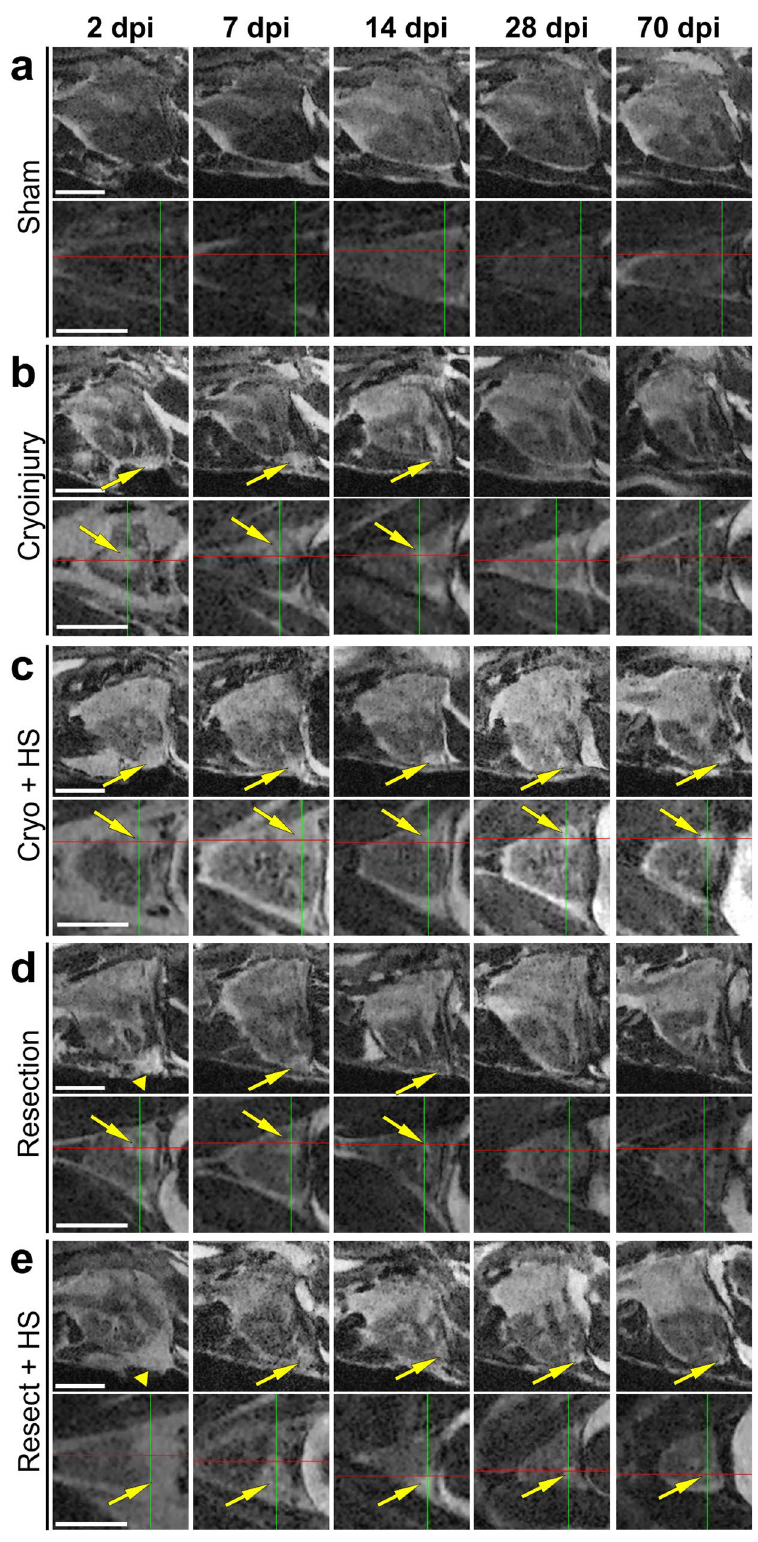
Figure 5. Comparing well and poorly healing hearts for 70 days post injury (dpi). (a–e) Optical sagittal and horizontal MR sections of 5 individual Tg ( hsp70l:dnfgfr1a-EGFP ) + / − adult fish imaged repeatedly over 70 days showing (a) a sham control ventricle (no injury but opened pericardium), and the regeneration process in (b) cryo-injured and (d) resected ventricles, and (c) cryo-injured plus heat-shock (HS) and (e) resected plus HS treated ventricles at 2, 7, 14, 28, and 70 days post injury (dpi). b + d serve as injured but not HS treated controls to visualise normal versus impaired ( c + e ) heart repair. Arrows point to the injury location and arrowheads indicate the blood clot following resection injury. Scale bar 1